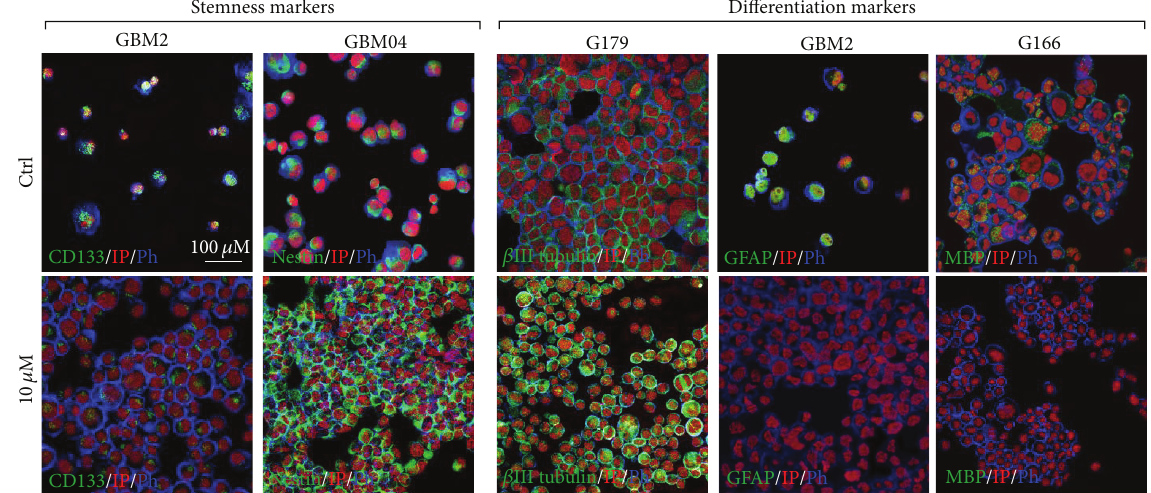
Figure5:Selectedrepresentativeimagesofimmunofluorescenceassaysforstemnessanddifferentiationmarkers.Immunofluorescenceassays were performed on untreated (Ctrl) and 10 𝜇 M Pio-treated GSCs for 72 hs. Each specific maker is in green; phalloidin is in blue and propidium iodide in